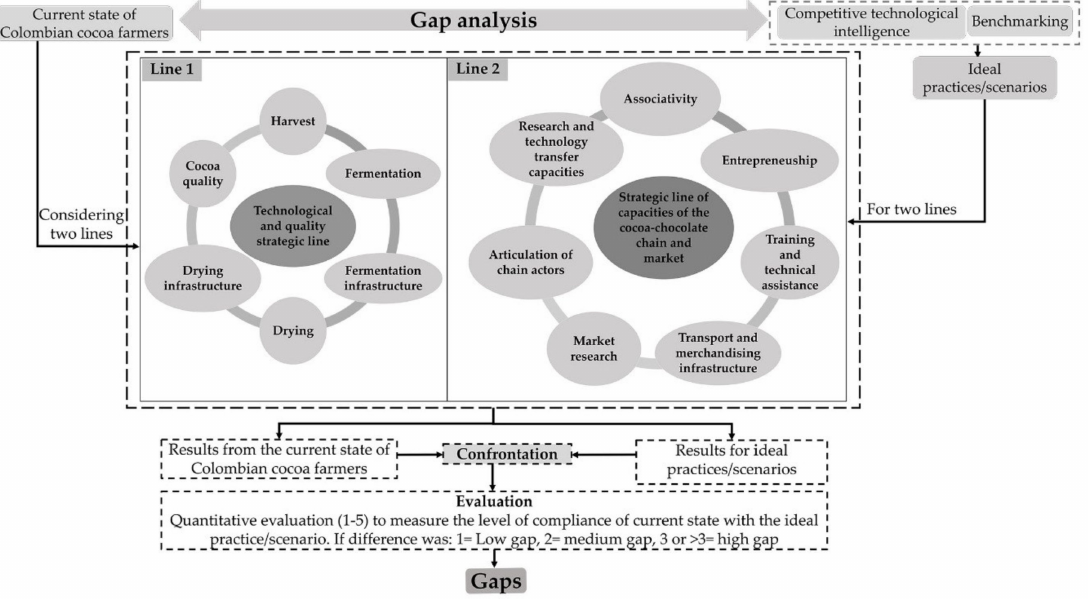
Figure 6. Scheme of the gap analysis